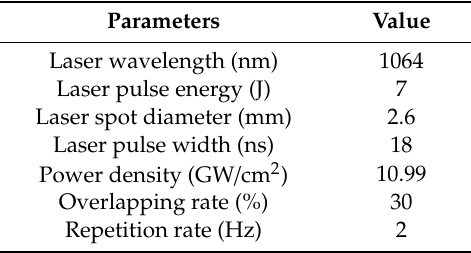
Table 2. LSP treatment